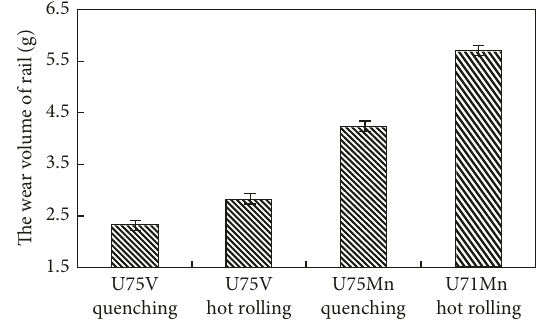
Figure 4: Wear loss of different